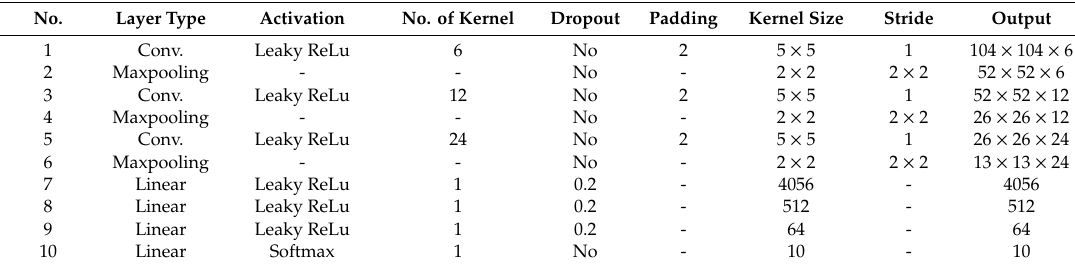
Table 1. The architectures and parameters of TDV-CNN.